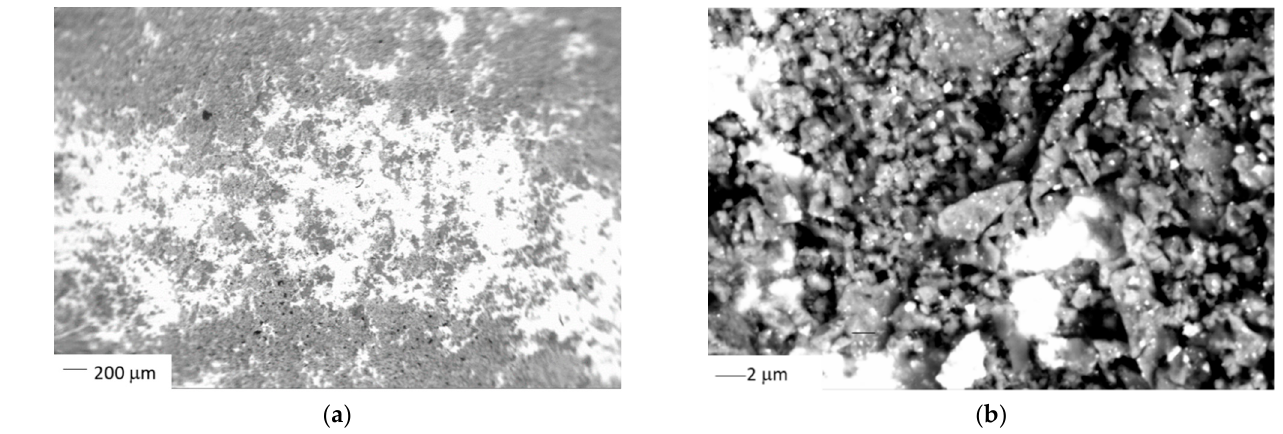
Figure 12. SEM micrograph ( a ) and a magnification ( b ) of wear tracks of WC-Co-Cr.